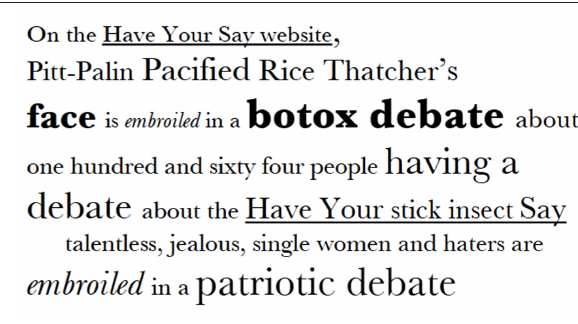
Figure 2: Marianne Morris, “Who Not to Speak To” (2009).